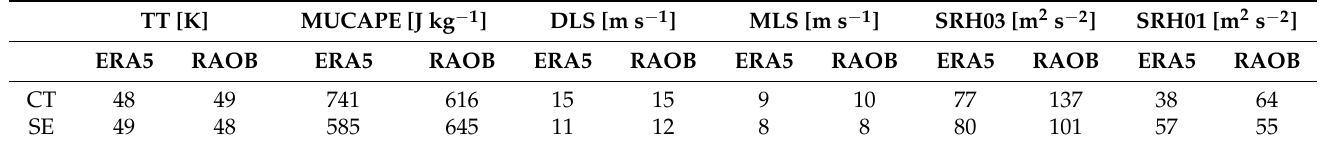
Table 1. Composite sounding-derived and convective parameters in the two sounding